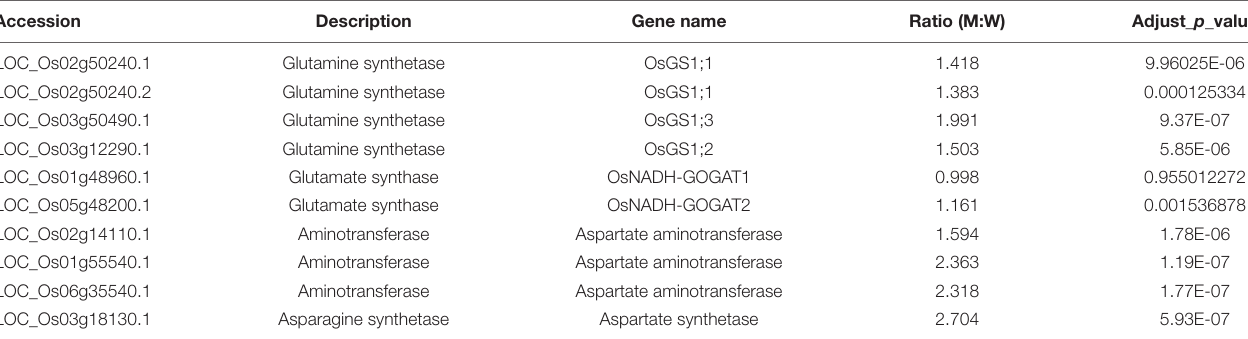
FIGURE 9 | KEGG pathway analysis. Differentially regulated proteins were used to perform KEGG analysis on clusterProfiler. Significant differences between ylc3 and WT were detected for proteins related to photosynthesis. Pathways including carbon metabolism, pyruvate metabolism, carbon fixation in photosynthetic organisms and photosynthesis-antenna proteins were enriched (corrected P -value < 0.05). TABLE 3 | Expression levels of aspartate metabolic pathway enzymes in